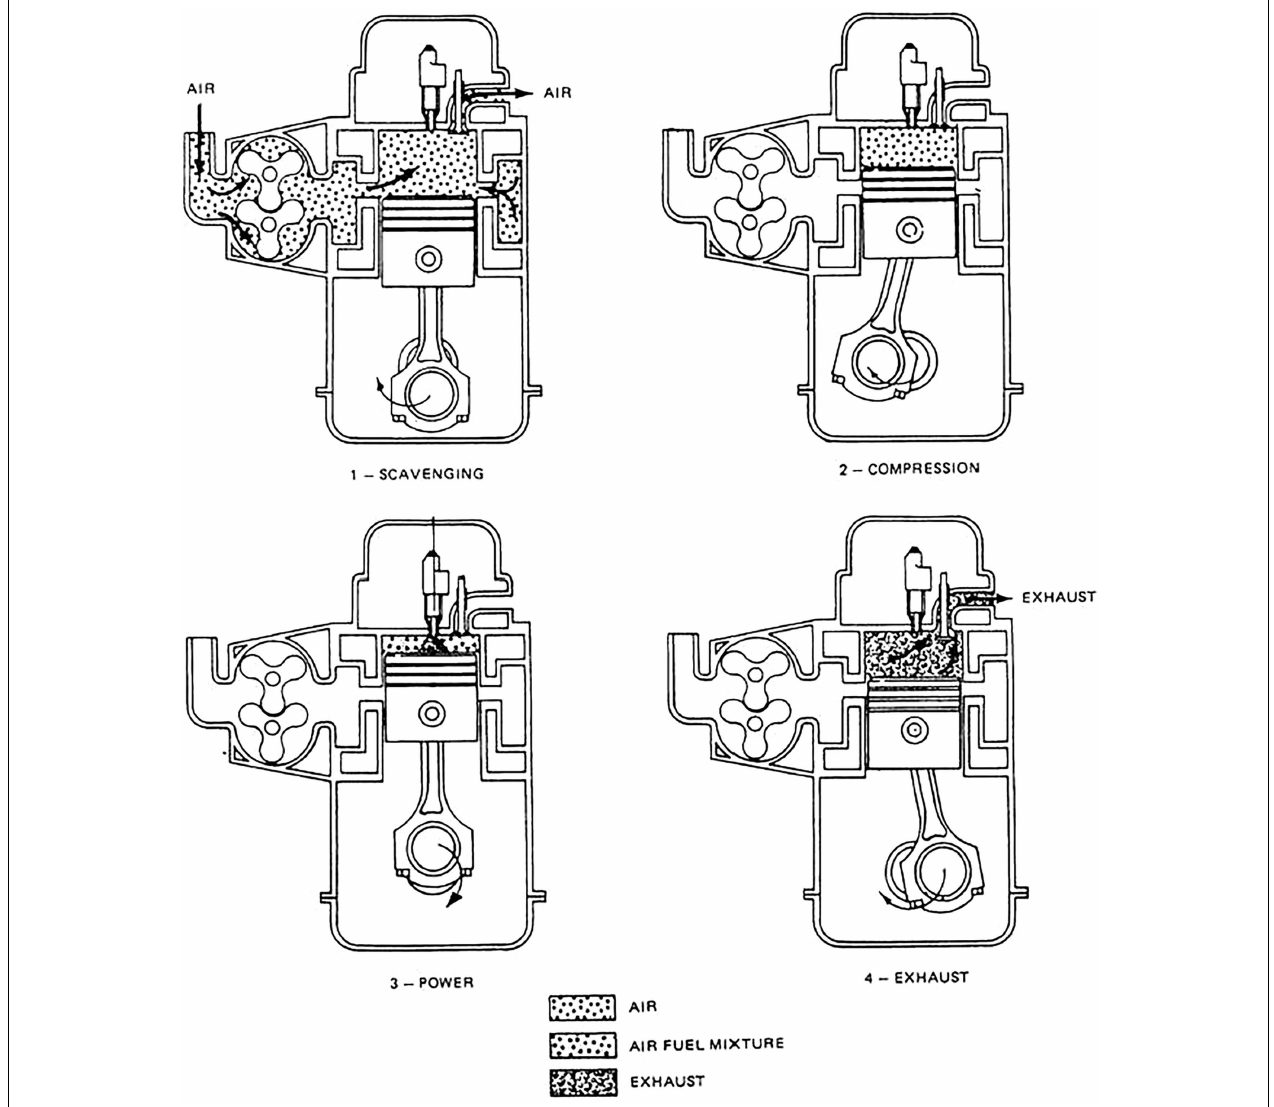
FIGURE 1 | Schematic of a two-stroke compression ignition engine . Image taken from